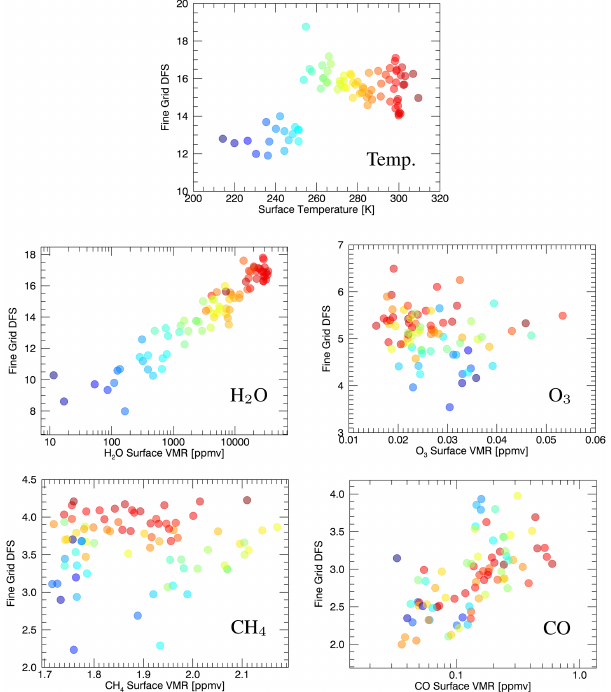
Figure 5. The DFS from the ensemble for temperature and trace gases as a function of their surface values. The points are colour coded by atmospheric surface temperature using the colour bar shown in Fig.